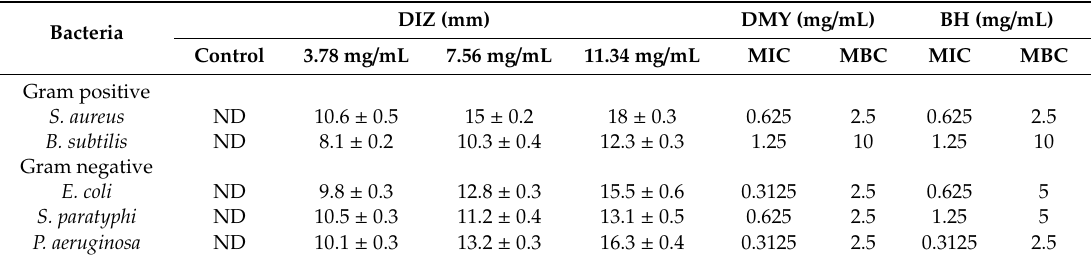
Table 1. The antibacterial ability of dihydromyricetin (DMY) against different bacteria. Bacteria Gram positive S. aureus Gram negative E. coli Values represent means of three independent replicates ± standard deviation (SD); ND represents not detected. BH: berberine hydrochloride; DIZ: diameter of the inhibition zone; MBC: minimum bactericidal concentration; MIC: minimum inhibitory concentration.